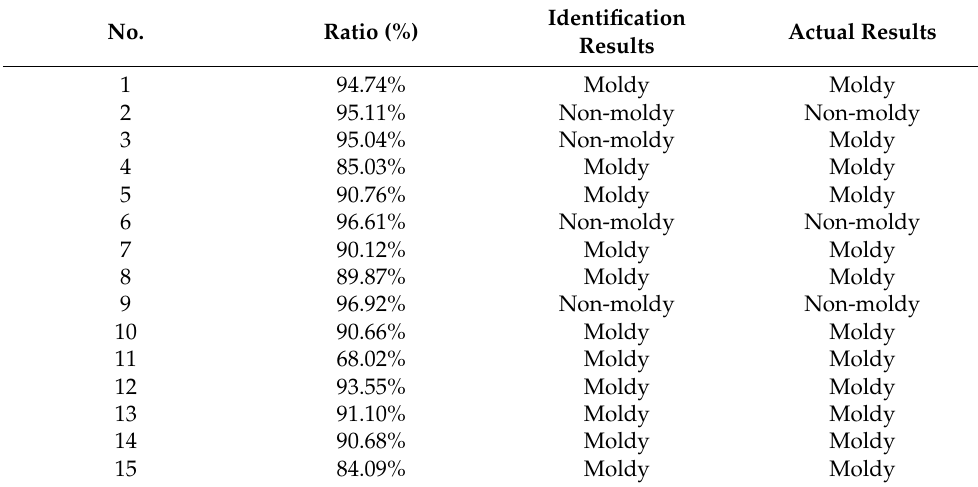
Table 3. Experimental results after recognition algorithm